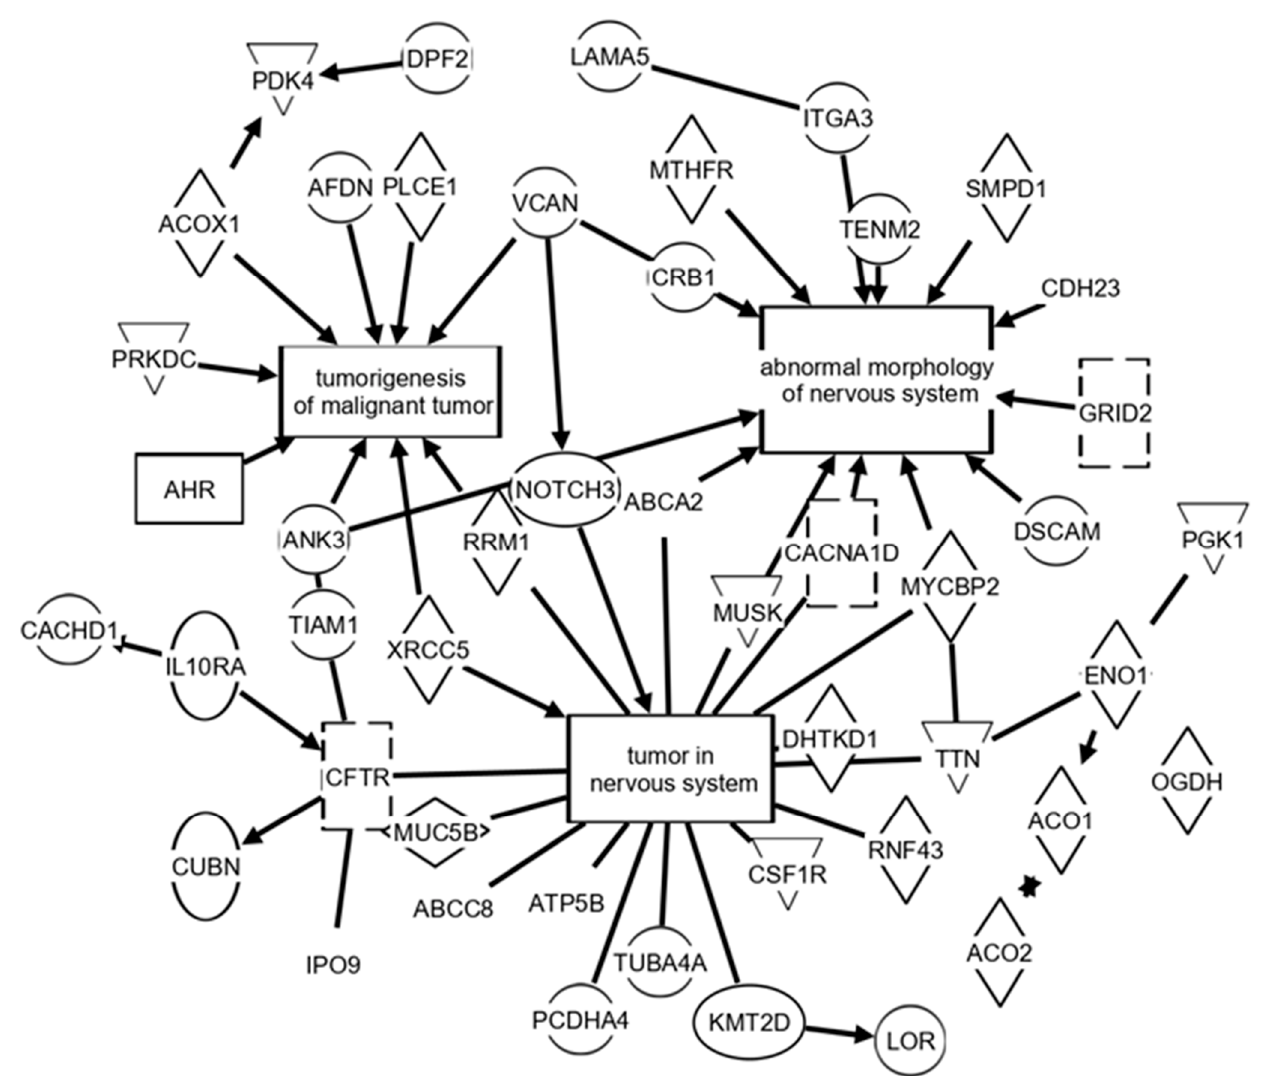
Figure 2. Tumorigenesis and nervous system pathways implicated by Ingenuity ® Pathway Analysis (IPA ® ) of serum MS/MS results from untreated vs. treated rat brain tumor model. Values below each protein abbreviation represent the base-2 logarithm [untreated (# hits)/treated (# hits)] utilized by IPA software. Following this format, negative numbers indicate an increase in the number of hits observed in the drug-treated tumor samples compared to untreated tumor samples.